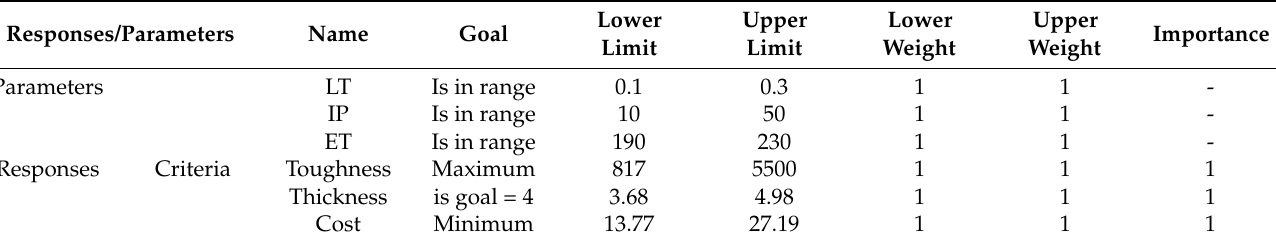
Table 11. Criteria, effective inputs, and responses of each parameter.